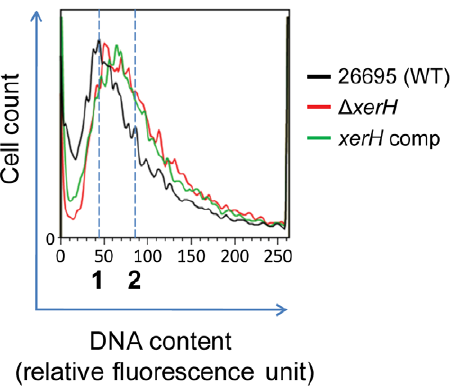
Figure 8. XerH is needed for gastric niche colonization. H. pylori X47 wild-type (WT) and isogenic D xerH and D ruvC mutants were used to inoculate five to ten eight-week old C57BL/6J mice. Mice were sacrificed and colonisation levels in stomachs were measured as described in the methods. Data is presented as a scatter plot with each point representing the CFU count of one mouse stomach, and the solid line the geometric mean 6 standard deviation for each group (WT, D xerH , and D ruvC